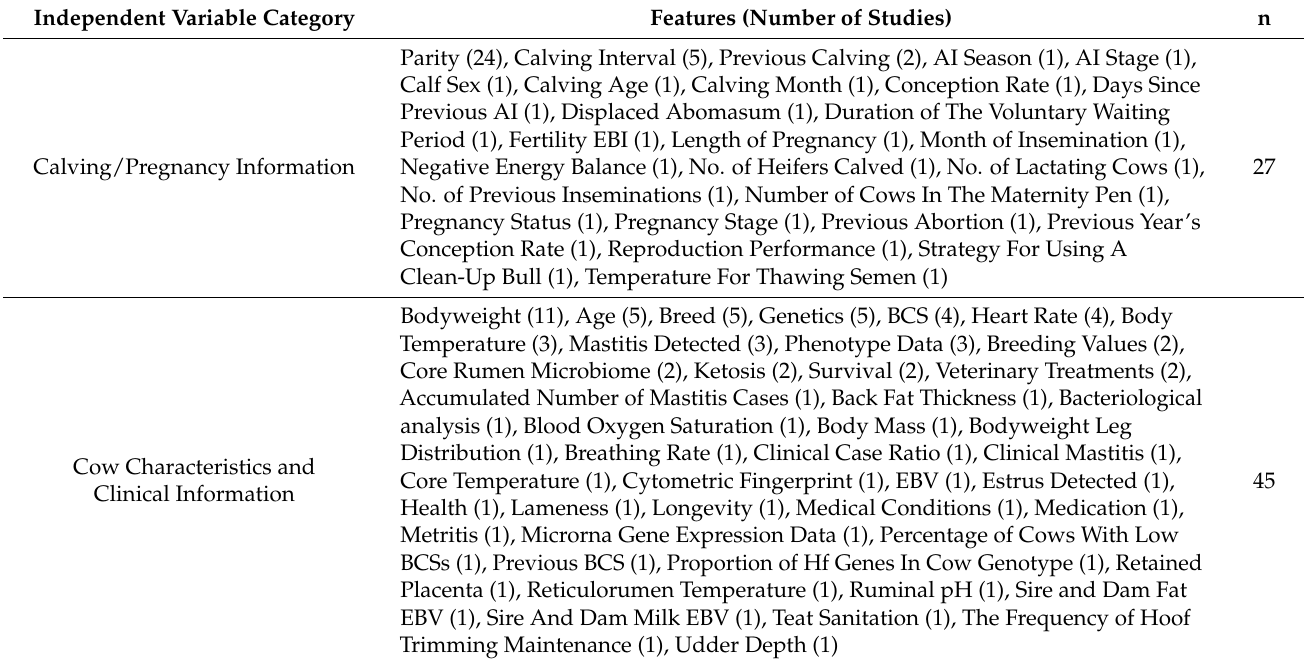
Table A2. Specific features used per feature